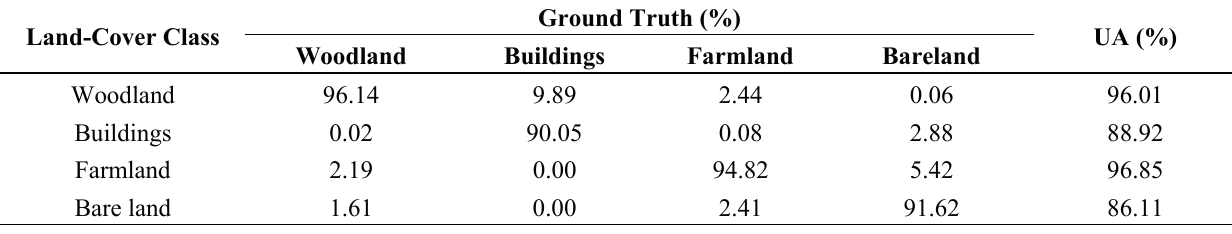
Table 9. The accuracy evaluation of the fusion result based on D-S evidence theory. Land-Cover